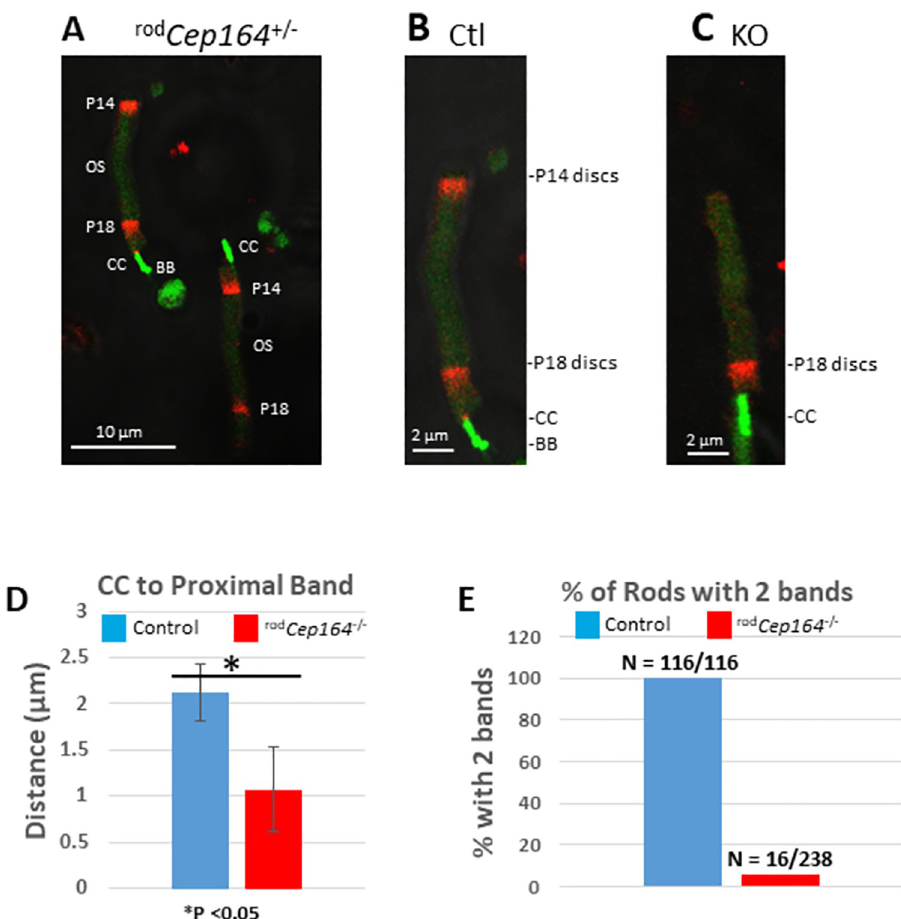
Fig 8. Intravitreal CF-568 hydrazide dye injection. Dye was injected at P14 (day1) and P18 (day 4) into rod Cep164 +/- control versus rod Cep164 -/- eyes on Egfp-Cetn2 + background and retinas were collected at P19 and dissociated rods were imaged. A , panel of rod Cep164 +/- control rods. B , single enlarged rod Cep164 +/- rod with P14 (day 4) and P18 (day 1) disc bands. C , single rod Cep164 -/- rod with new P18 discs, but no P14 discs. D , statistical evaluation of the distance between CC-tip and center of P18 band in control (blue) and rod KO (red) (n = > 100), � p < 0.05 t -test. E , % rods with P14 and P18 bands in control versus mutant (n = > 100).